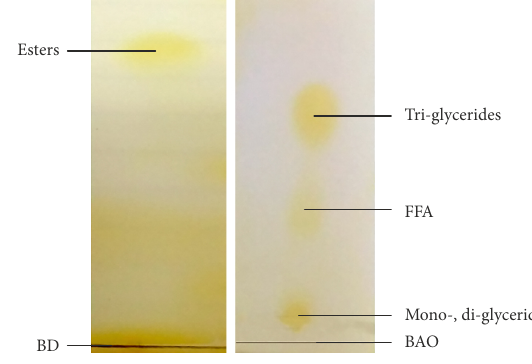
BD Figure 8. The TLC photographs of BAO and its optimal BD sample